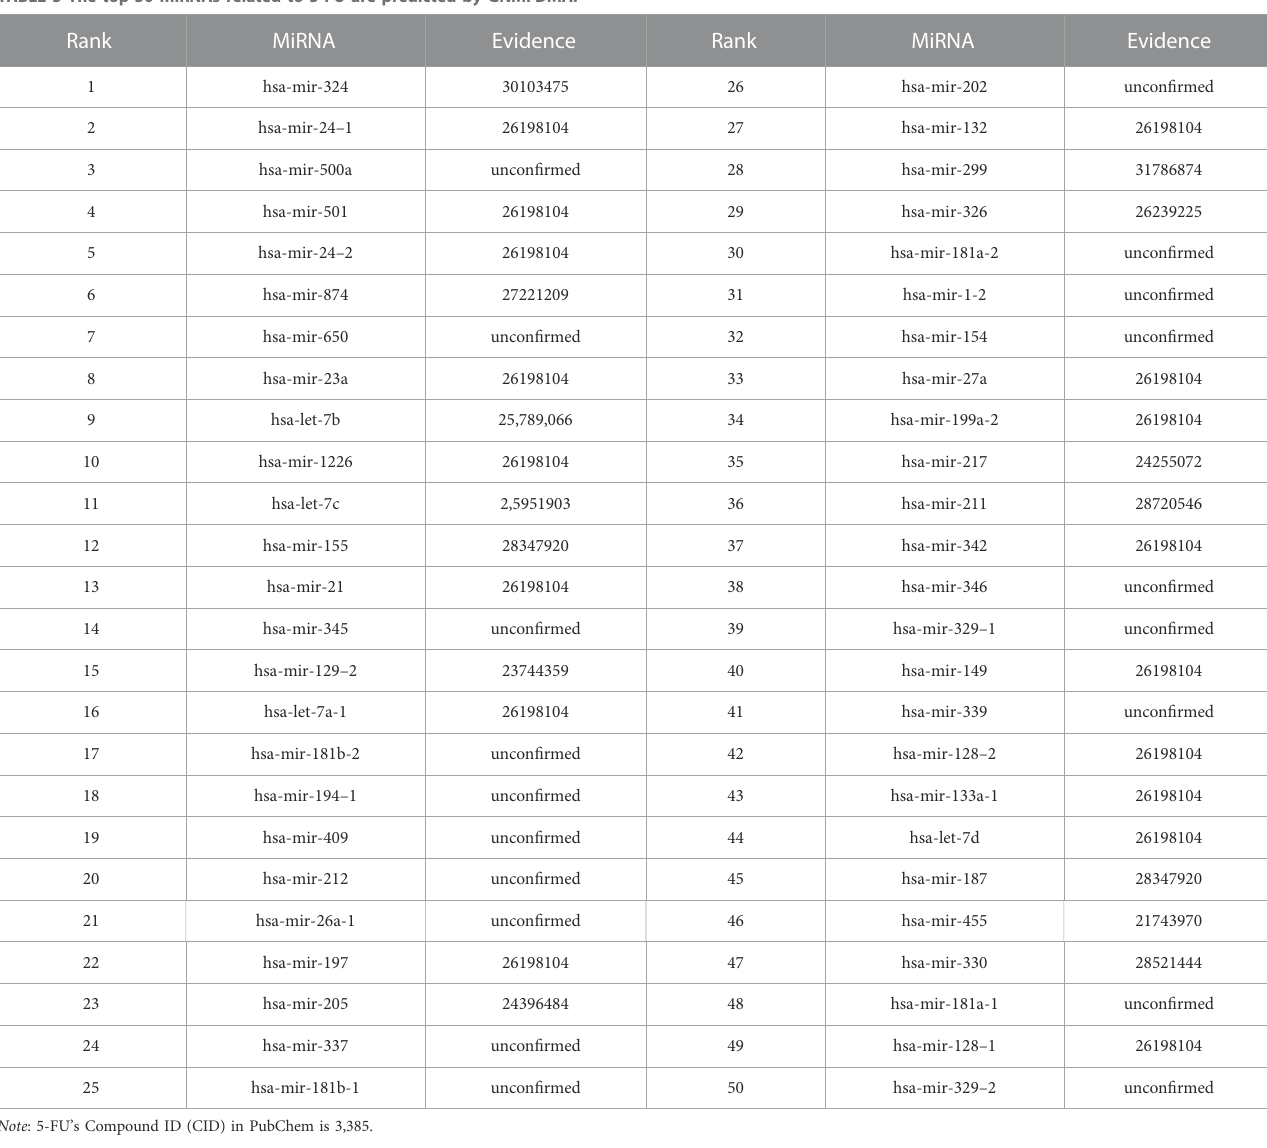
TABLE 5 The top-50 miRNAs related to 5-FU are predicted by GNMFDMA.